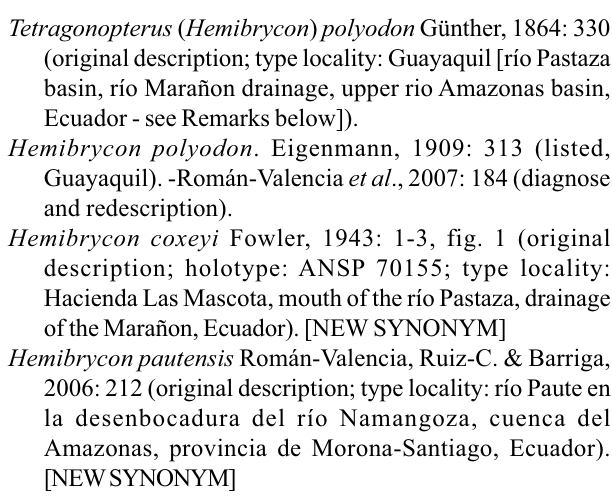
scale rows above lateral line (8 vs . 6-7); from H . dariensis , H . divisorensis , H . surinamensis and H . taeniurus by the number of lateral line scales (42-45 vs . 39-42, Fig. 3); from H . huambonicus by the number of caudal peduncle scales (16 vs . 18-20), head length (20.9-22.9 vs . 22.0-26.0% SL), and upper jaw length (43.7-45.6 vs . 45.2-52.6% HL); from H . inambari by the number of scales along anal-fin base scale sheath (14-23 vs . 6- 10); from H . jabonero by the number of caudal peduncle scales (16 vs . 14), and number of scale rows below lateral line (6 vs . 4- 5); from H . jelskii by the number of maxillary teeth (7-10 vs . 8- 17), and by the size of humeral spot (6-7 vs . 7-9 horizontal series of scales); from H . metae by the number of cusps of second tooth of premaxillary inner row teeth (5 vs . 7), caudal peduncle length (14.4-16.6 vs . 11.1-14.8% SL), and head length (20.9-22.9 vs . 22.1-25.0% SL); from H . quindos by the number of scale rows above and below of lateral line (8 and 6 vs . 6-7 and 4-5); from H . rafaelense by the number of predorsal scales (15-17 vs . 10-13), orbital diameter (29.5-34.1 vs . 36.6-43.6% HL), and interorbital width (32.1-35.3 vs. 34.7-41.5% HL); and from H . raqueliae and H . yacopiae by the number of predorsal scales (15-17 vs . 10-14), and by the number of cusps of first maxillary tooth (3 vs . 5 in H . raqueliae ). Furthermore, H . polyodon can be distinguished from H . surinamensis and H . divisorensis by the absence of a wide black asymmetrical spot covering base of caudal-fin rays, and from H . dariensis by the absence of pigment in the distal tip of rays just above and below to middle caudal-fin rays.